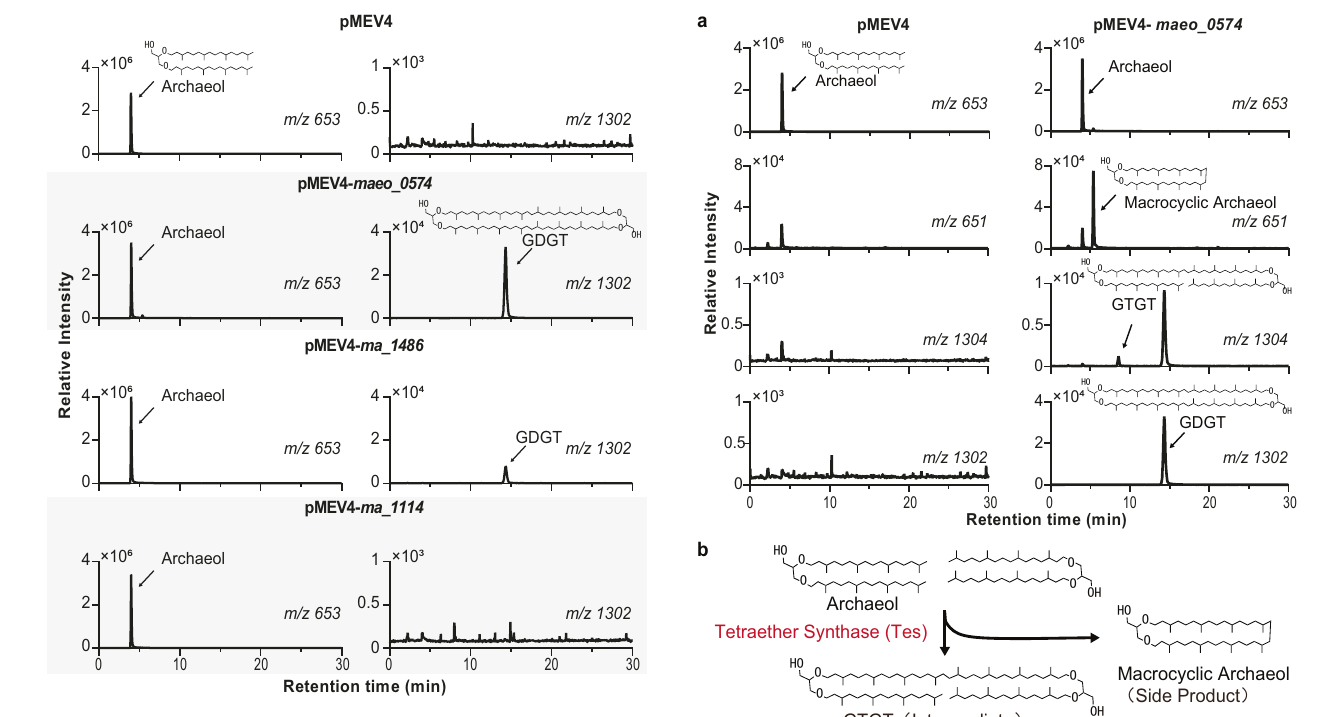
Fig. 1 Tes (Maeo_0574 or MA_1486) is suf fi cient for GDGT synthesis. LC-MS extracted ion chromatograms of acid hydrolyzed lipid extracts of M. maripaludis wild type (WT) with empty plasmid pMEV4 or ma_1114 heterologous expression showing only production of archaeol, and M. maripaludis WT with maeo_0574 or ma_1486 heterologous expression producing GDGT. Mass spectra are shown in Supplementary Fig. 1. Source data are provided as a Source Data fi le. Fig. 2 GDGT biosynthesis pathway, intermediate, and side product. a